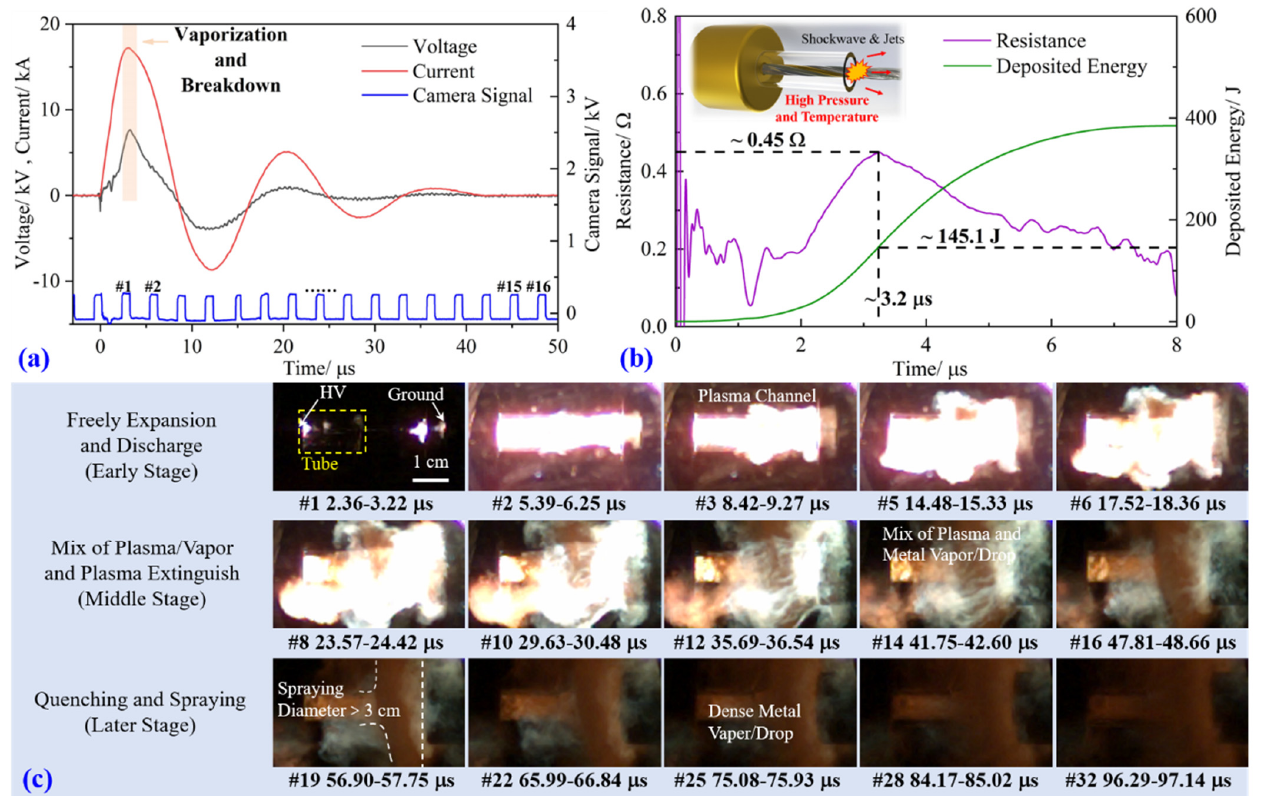
Figure 2. Intertwined wire explosion made of Fe, Co, and Ni under the directional spraying device: ( a ) current and voltage waveforms; ( b ) resistance and deposited energy waveforms; ( c ) high-speed (self-emission) images.